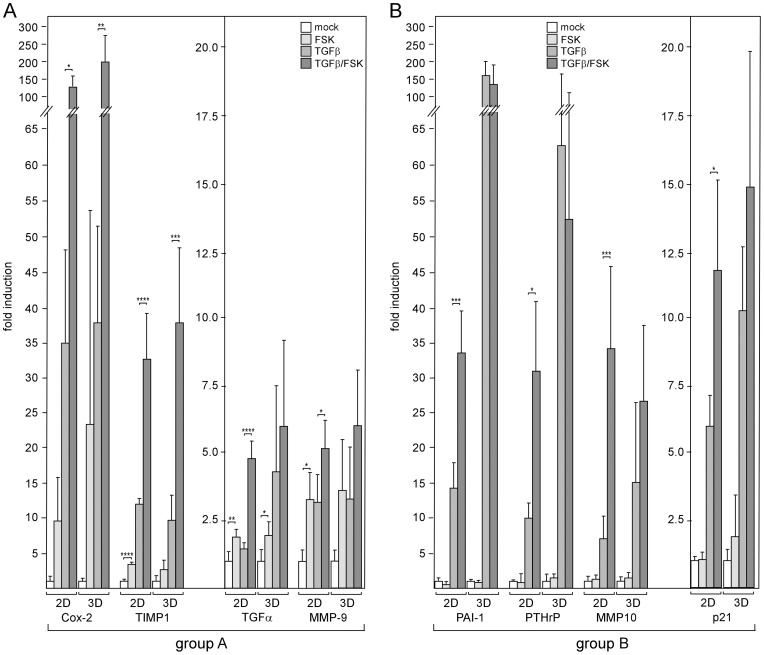
cAMP increases responses of tumor-relevant genes to TGFβ.MDA-MB-231 cells were incubated with forskolin or TGFβ1 or both or mock-treated for 24 h, lysed and analyzed for RNA levels of TIMP-1, Cox-2, PTHrP, MMP10, PAI-1, TGFα, MMP9 and p21 by Q-RT-PCR. Genes were grouped based on their abilities to respond to forskolin in the absence and presence of TGFβ (group A) or only in the presence of TGFβ (group B) in 2D-cultured cells. For graphical reasons, genes in each group were sorted by their potencies to respond to TGFβ plus forskolin. Genes showing fold induction in response to TGFβ plus forskolin >15 appear in the left graph, those displaying fold induction ≤ 15 appear in the right graph of each group. Each bar represents the mean value ± SD of 3–5 independent experiments. * p-value <0.05, ** p-value <0.01, *** p-value <0.005, **** p-value <0.001 (Student’s t-test).